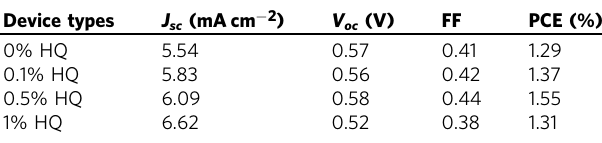
Table 2 Photovoltaic performances of the Chl-derivative- based bio-solar cells with different HQ doping